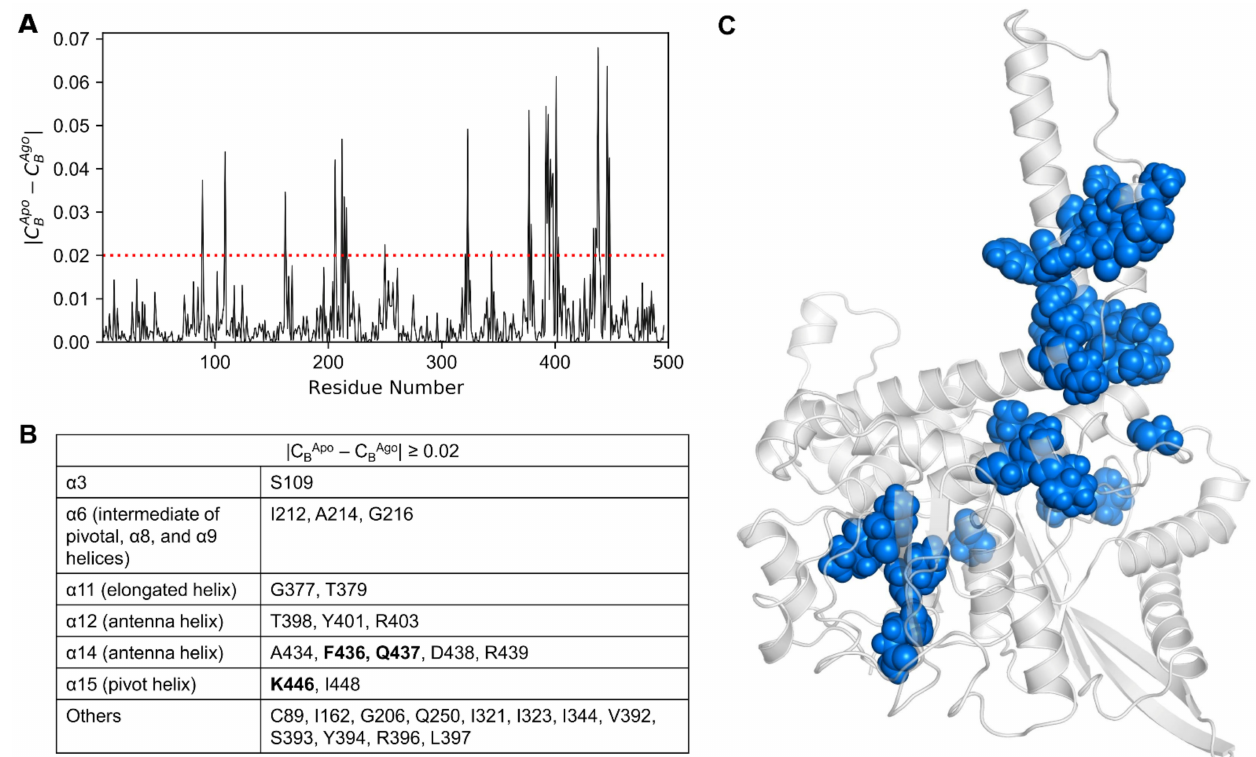
Figure 7. ( A ) Differences in C B values calculated for the apo and agonist-bound GDH states. ( B ) Key residues satisfying the condition | C B Apo − C B Ago | ≥ 0.02, along with their corresponding protein segments (listed in the table). Mutation data available for residues are shown in bold. ( C ) Residues with | C BApo − C BAgo | ≥ 0.02 are shown on the minimized apo structure as dodger blue